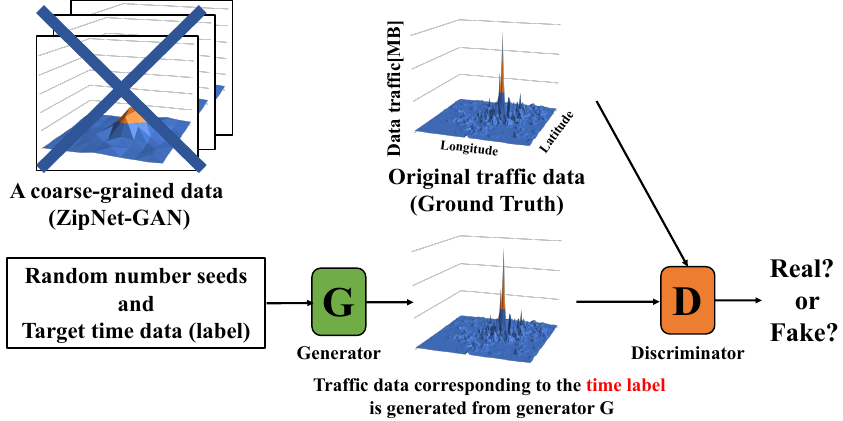
Figure 2. The abstraction of a scheme for generating mobile traffic data by using CSR-GAN (proposed scheme). Our scheme aims to generate the real dataset without coarse-grained data, whereas ZipNet- GAN uses the coarse-grained